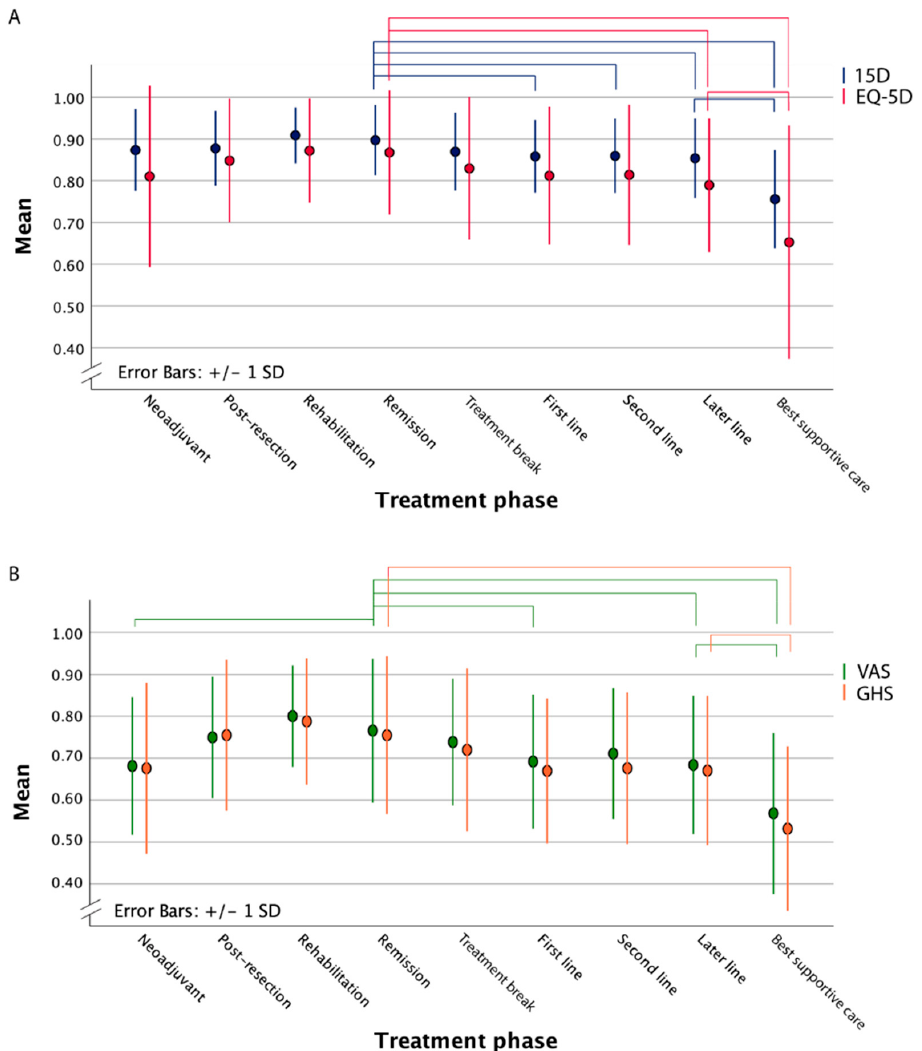
Figure 2. The mean health-related quality of life measured with the 15D and EQ-5D ( A ) and the VAS and QLQ-C30 global health ( B ) scores during treatment trajectory. Statistically significant differences between treatment phases are marked with brackets. Abbreviations: VAS = Visual Analogue Scale, GHS = Global Health Status.